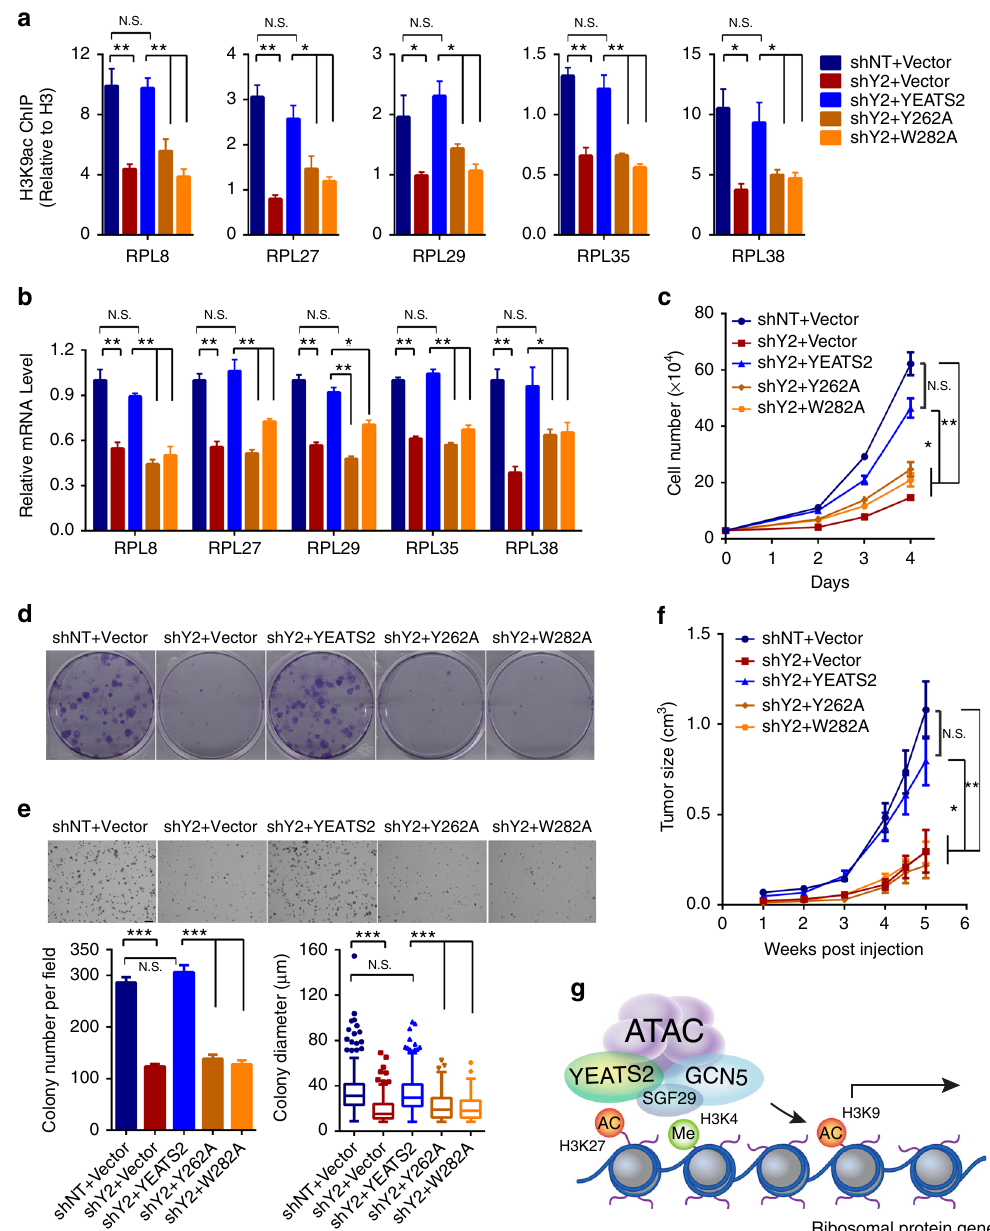
Fig. 6 The YEATS domain of YEATS2 is required for ATAC-dependent ribosomal protein gene expression and tumor cell survival. a qPCR analysis of H3K9ac ChIP in the promoters of the indicated ribosomal protein genes in control (shNT) and YEATS2 KD (shY2) H1299 cells ectopically expressing shRNA-resistant WT YEATS2 or the indicated mutants. b qRT-PCR analysis of the expression of ribosomal protein genes in cells as in ( a ). In a and b , error bars indicate S.E.M. of at least three biological replicates. N.S. not signi fi cant; * p < 0.05; ** p < 0.01 (Student ’ s t -test). c Cell proliferation assay of cells as in ( a ). Cells (mean ± S.E.M., n = 3) were counted for 4 days after seeding. Error bars represent the S.E.M. N.S.; * p < 0.05; ** p < 0.01 (Student ’ s t -test). d Clonogenic assay of cells as in ( a ). Colonies were stained and photographed 7 days after seeding. e Anchorage-independent growth assay of cells as in ( a ). Cells (mean ± S.E.M., n = 4 – 6) were stained and photographed 3 weeks after seeding. Colony numbers (bottom left) and diameters (bottom right) were measured using ImageJ software. Error bars represent the S.E.M. Scale bar, 200 µ m. N.S.; *** p < 0.001 (Student ’ s t -test). f Volumes of tumors (mean ± S.E.M., n = 10) of the H1299 cells as in ( a ) subcutaneously transplanted into immunode fi cient nude mice. Tumors were monitored for 5 weeks after transplantation. N.S.; * p < 0.05; ** p < 0.01 (Student ’ s t -test). g Working model: the YEATS2 subunit of the ATAC complex recognizes H3K27ac through its YEATS domain and stabilizes the ATAC complex at target promoter regions to maintain local histone acetylation and gene expression,